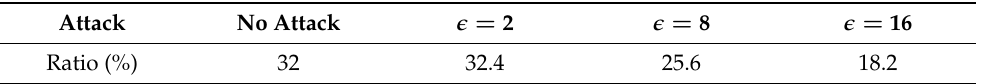
Table 5. Portion of images whose inference results do not change over the LPF kernel size changes.